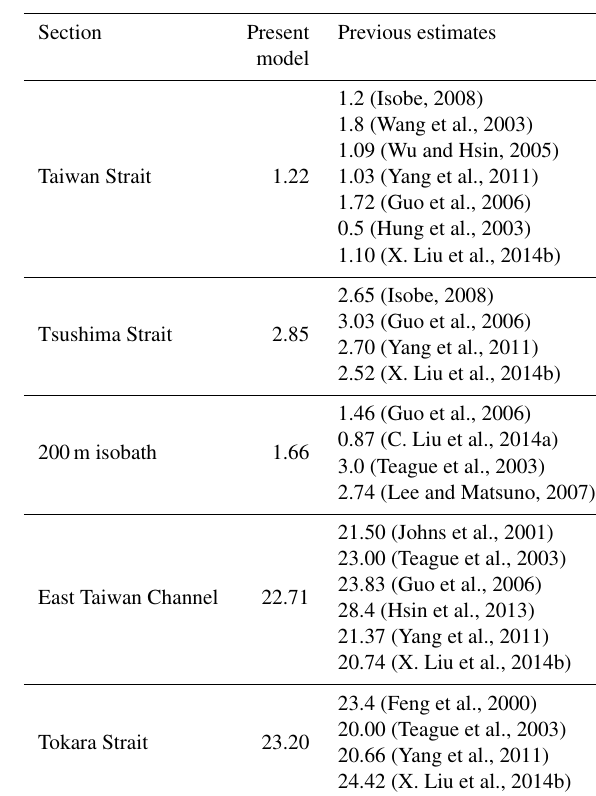
Table 1. Annual-mean volume transports (Sv = 10 6 m 3 s − 1 ) through various sections. The sections are shown in Fig. 2 using blue dashed